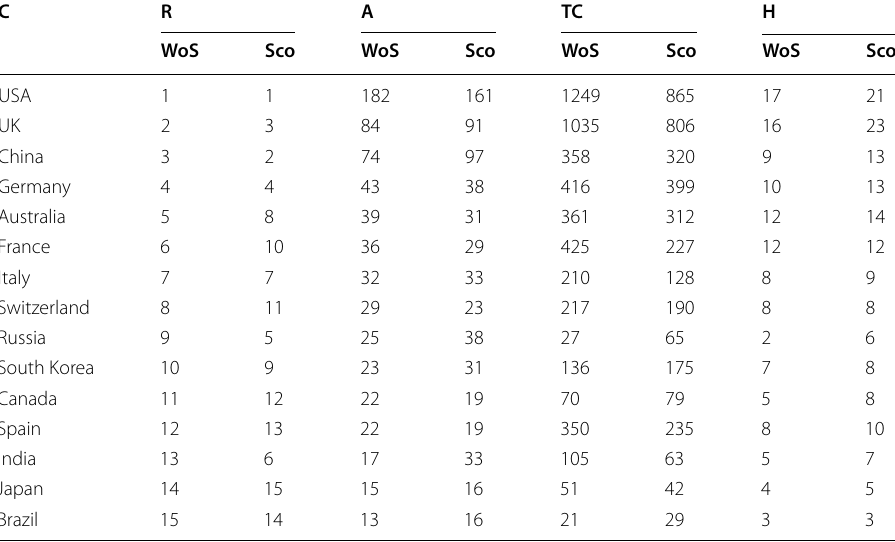
Table 6 Distribution by